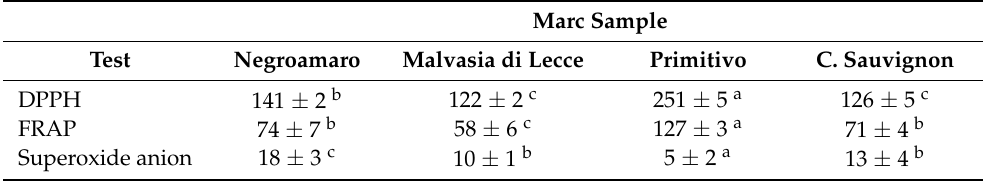
Table 6. Antioxidant activity tests (DPPH, FRAP and superoxide anion). The analyses were carried out on the SPE purified grape marcs. The results are reported as TEAC ( µ mol Trolox equivalents (TE)/g DW) for DPPH and FRAP test and in IC 50 µ g/mL for superoxide anion test. Different letters correspond to statistically different means (Duncan’s test, n = 3, p <